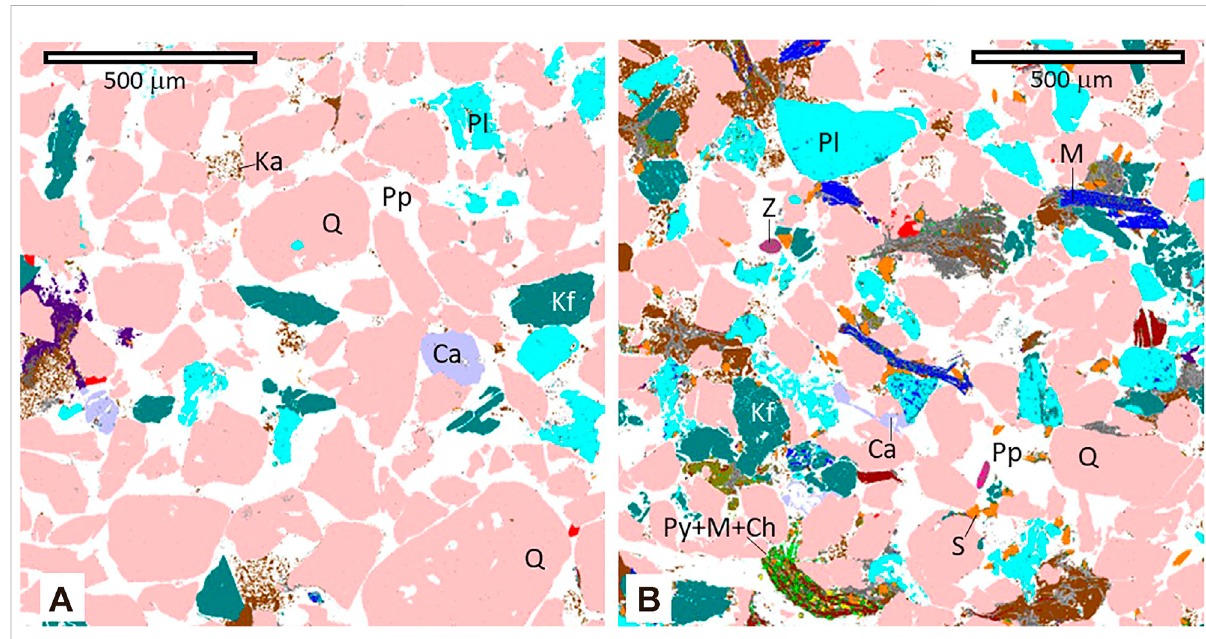
FIGURE 7 Lower Cretaceous marine fan sandstones from the Moray Firth Basin, Central North Sea, United Kingdom (mineral colour index in Figure 3). (A) Poorly-sorted, high porosity sand, rich in quartz (Q) containing grains with a wide variety of grain shapes. Detrital calcite (Ca), K-feldspar (Kf) and plagioclase (Pl) are present. This sandstone has a small amount of kaolinite but little other cement despite being buried to about 2,000 m (72 ° C). (B) Poorly-sorted, medium porosity, quartz-, lithic-, muscovite (M)-,plagioclaseand K-feldspar-bearing sand containing grains with a wide variety ofshapes,buriedtothesamedepthasthesampleinFigure7A.Siderite(S)andcalcitearepresentasminorcements.Thelowerporosityofthesample in 7B compared to 7A is due to the mechanical and chemical breakdown of lithic grains.